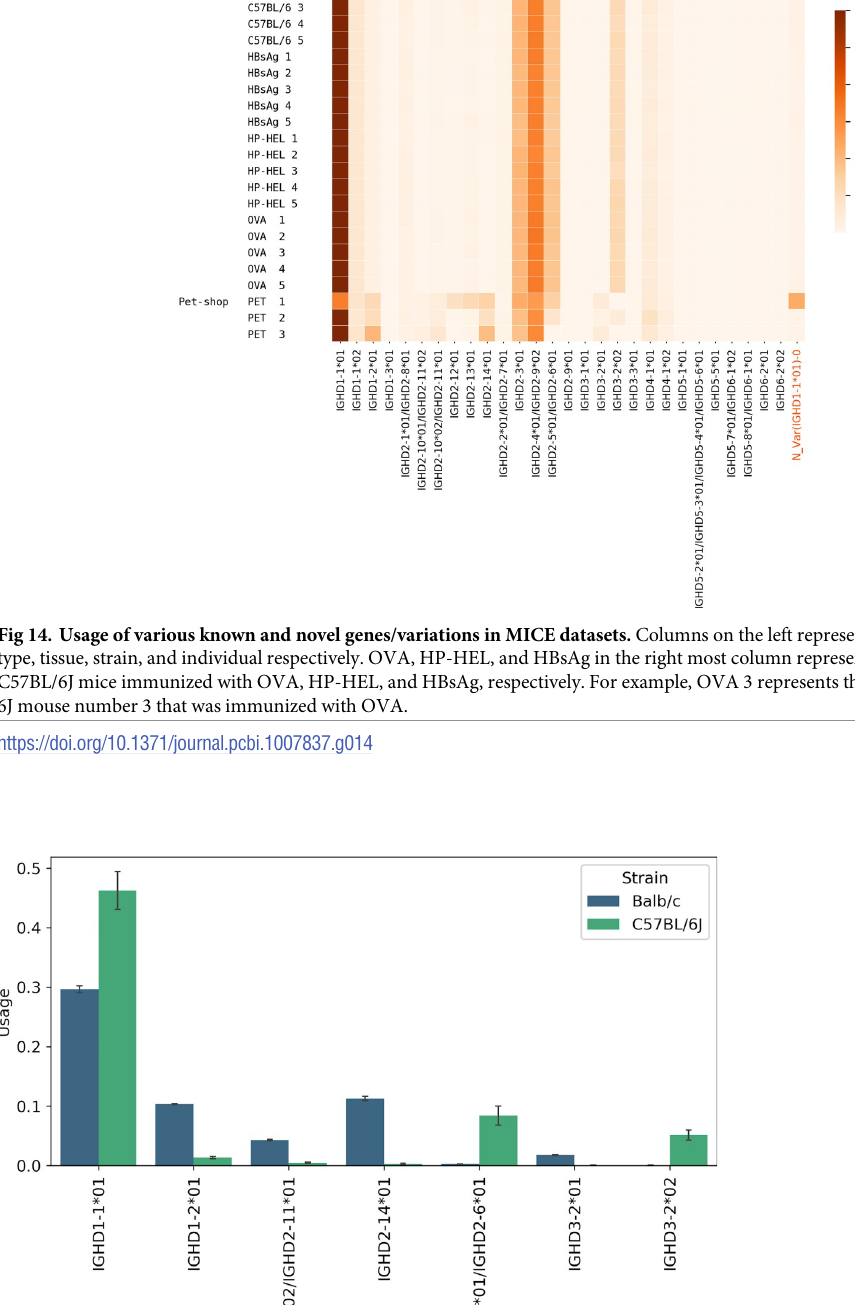
PLOS Computational Biology | https://doi.org/10.1371/journal.pcbi.1007837 April 27,